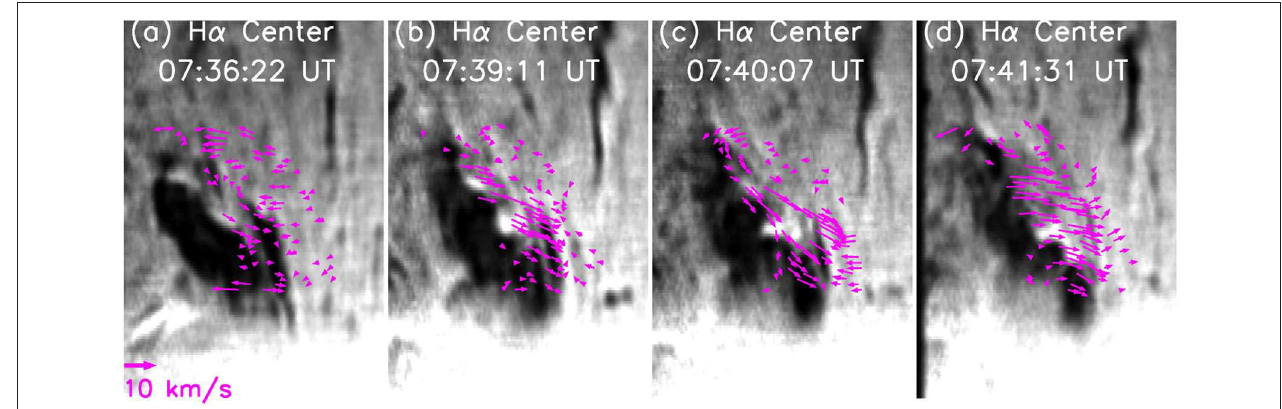
FIGURE 4 | Sheared flow along bubble boundary as seen in the early evolution phase of the bubble. (a–d) Sequence of images in the H α line-center along with the flow-map, derived using NAVE procedure, show the oppositely directed flows along the right boundary of the